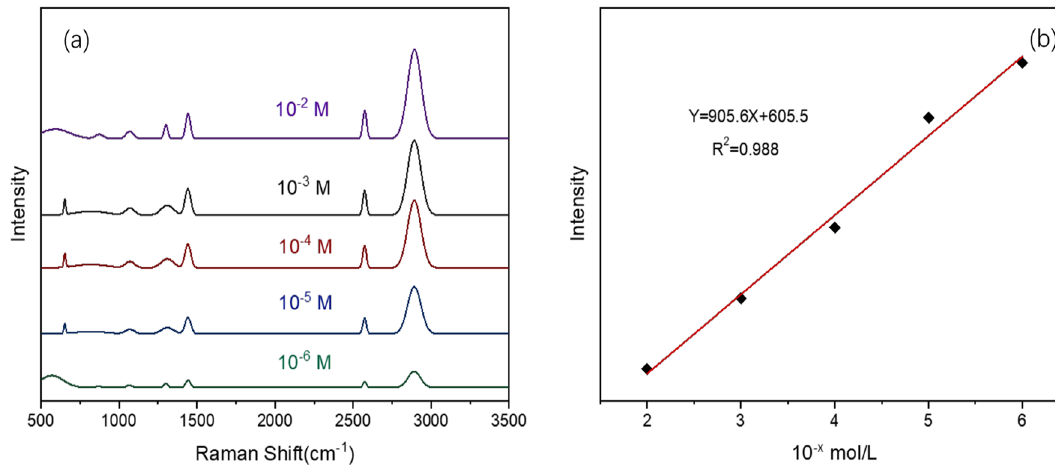
Fig. 7 Glucose detection spectrum Table 1 Documented Raman SERS spectra of glucose and peak